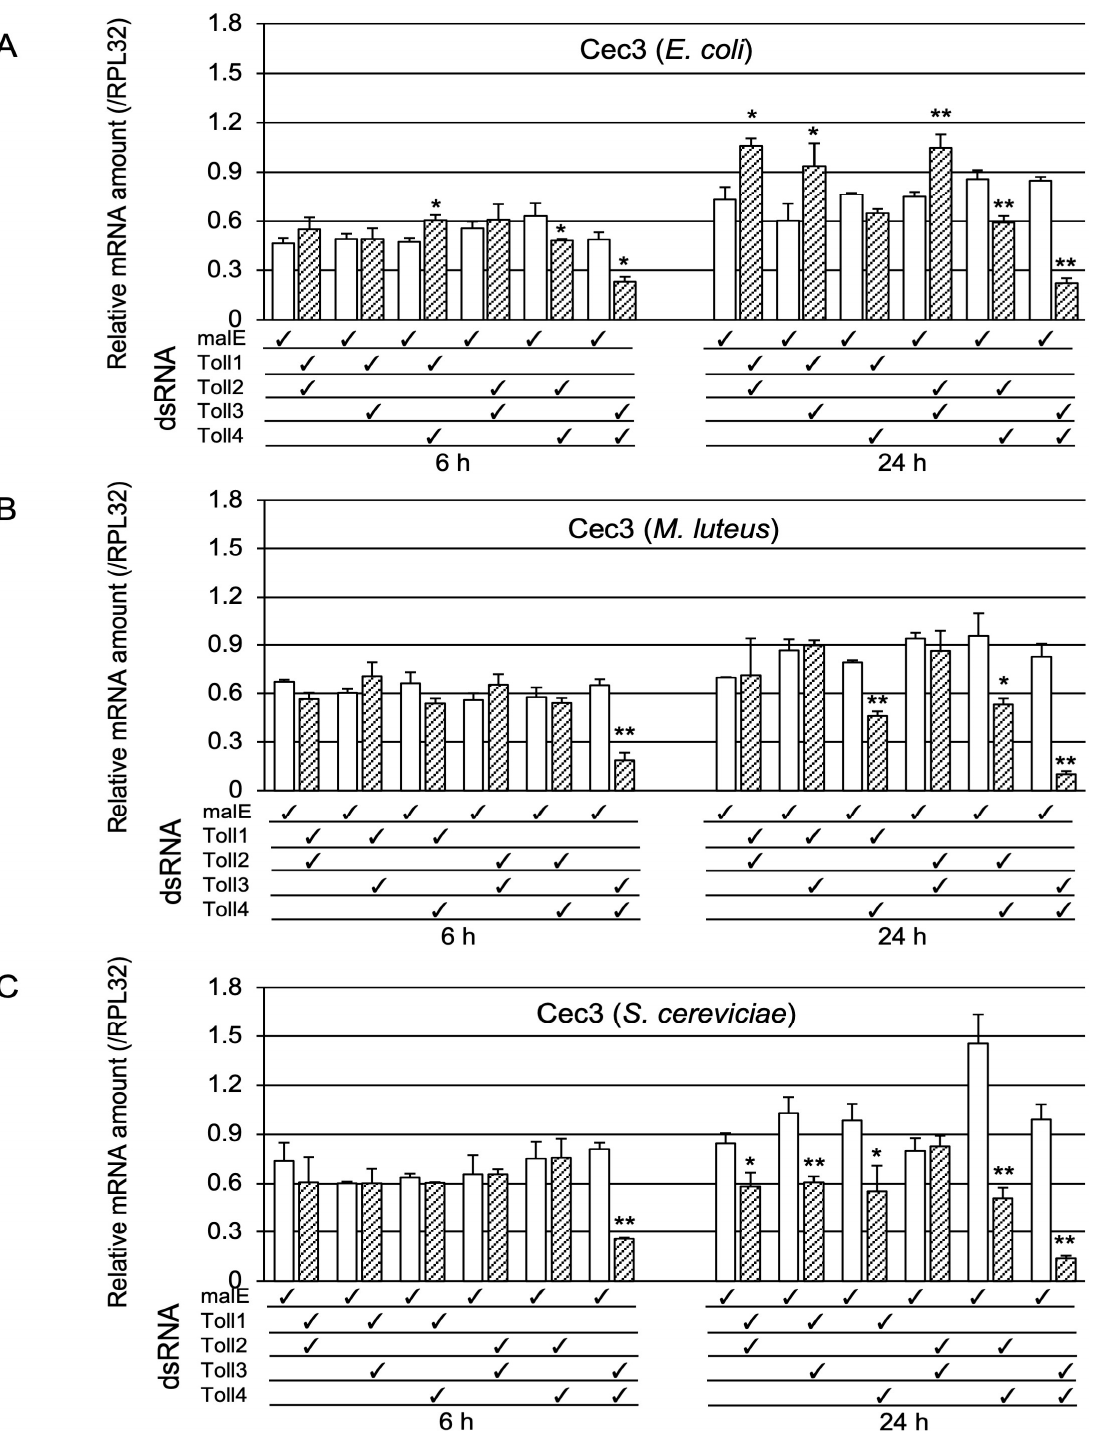
Figure 6. Effect of double knockdown of Toll genes on Cec3 induction. mRNA levels of Cec3 in pupae treated with malE dsRNA (open bars, control) and pupae with double knockdown (check marked) of Toll1 − 4 genes (shaded bars) after challenge with either Ec ( A ), Ml ( B ), or Sc ( C ). The methods of sample preparation and mRNA level measurement were the same as those described in Figure 3. Experiments with three animals were independently repeated three times, and each column represents the mean ± S.D. Asterisks and double-asterisks indicate p < 0.05 and p < 0.01 compared to Uc samples, respectively, according to Student’s t